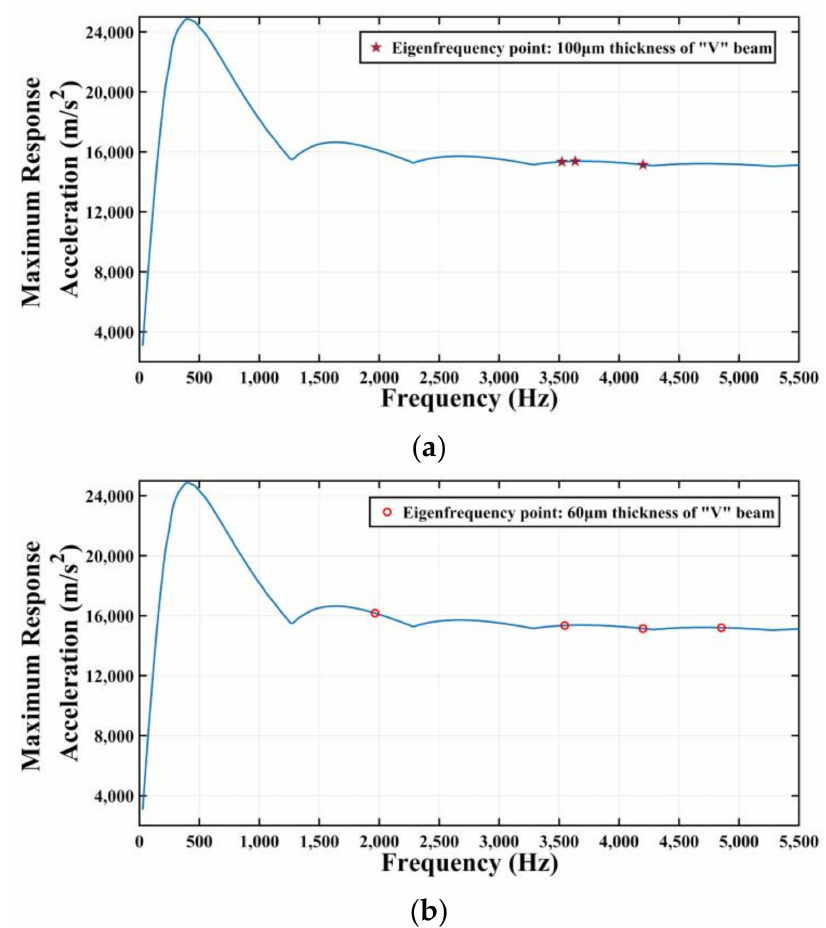
Figure 16. ( a ) Natural frequency distribution with 100 µ m thickness of V-shaped beam. ( b ) Natural frequency distribution with 60 µ m thickness of V-shaped